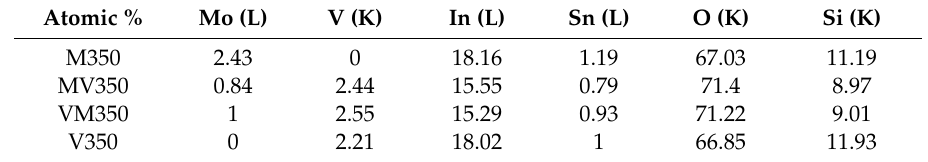
Figure 3. Field emission scanning electron microscope (FE-SEM) images of MoO 3 /V 2 O 5 hybrid nanobilayers heated at 350 °C for 2 h in air. ( a ) M350, ( b ) MV350, ( c ) VM350, ( d ) V350. The inset of ( b ) and ( c ) are the cross-section images of the samples MV350 and VM350. Table 1. Element compositions of MoO 3 /V 2 O 5 hybrid nanobilayers heated at 350 °C for 2 h in air.